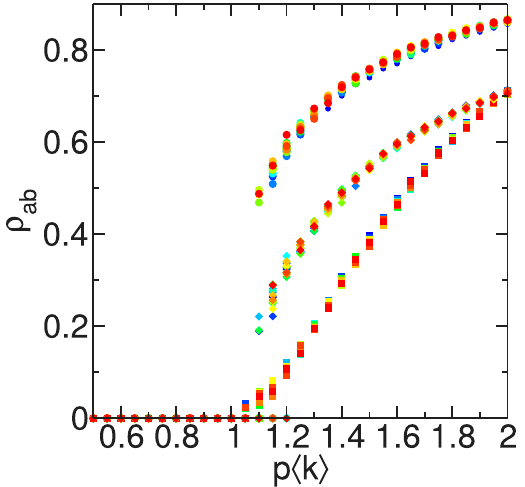
Figure 4. Cooperative contagion with interactions defined by uncorrelated contact sequences. The system has a phase transition at 〈 〉 = p k 1 , which becomes discontinuous as the secondary infection probability q is c increased. Symbols denote different values of q : = q p (squares), 〈 〉 = q k 2 (diamonds) and 〈 〉 = q k 3 (circles). Colors represent different interaction radii d , changing gradually from = d 20 (blue) to = d 100 (red) with ∆ = d 5